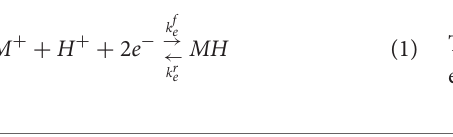
TABLE 1 | Input parameters used in the fitting of the model with their symbols, values, and units. Parameter